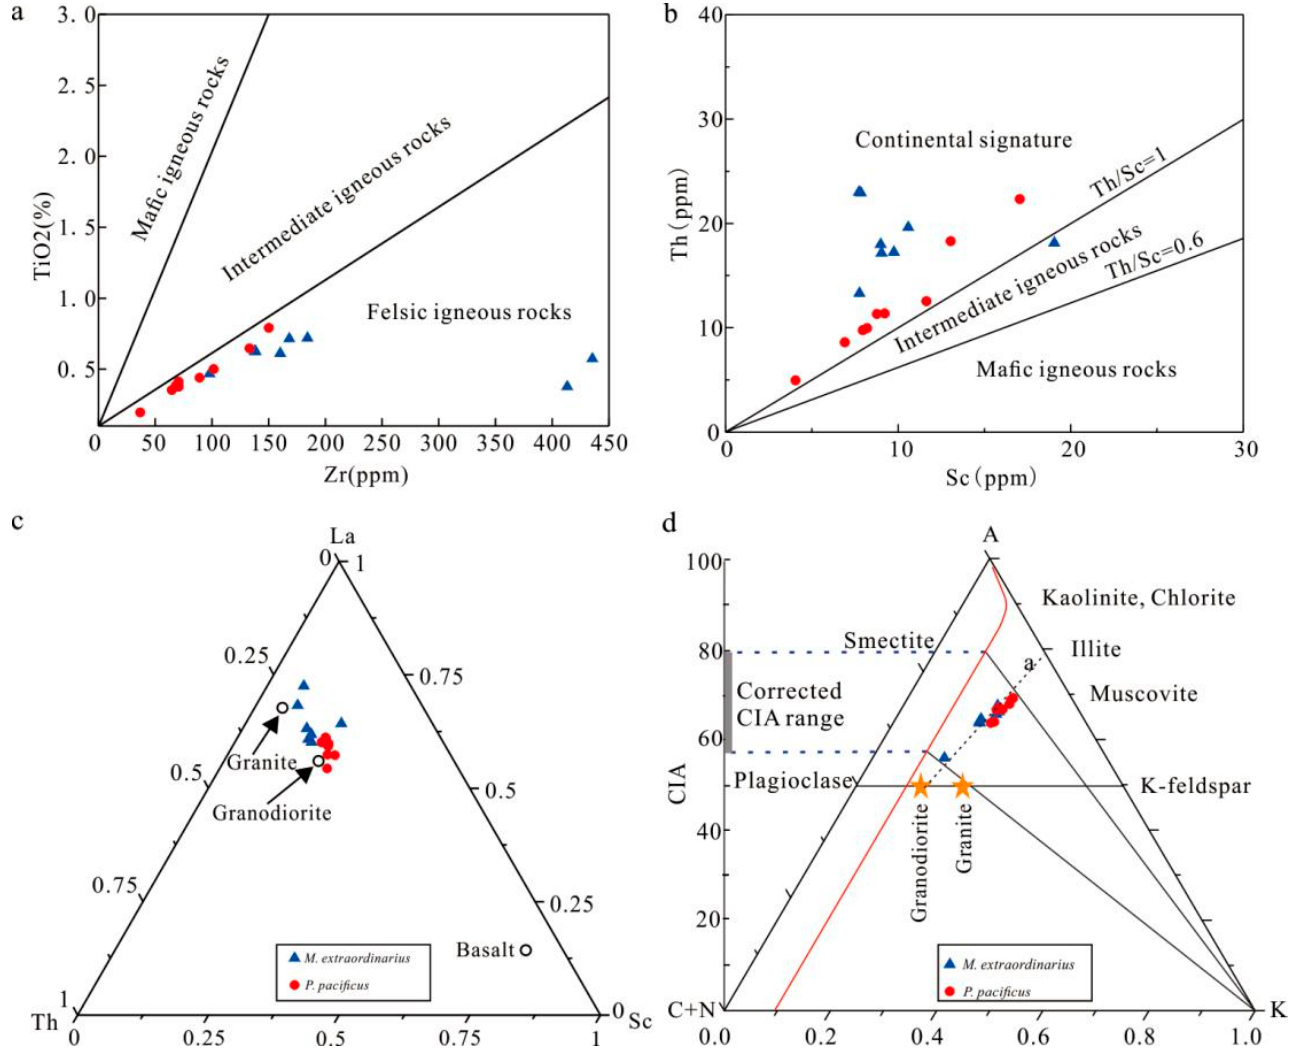
Figure 7. ( a ) Crossplot of TiO 2 versus Zr; ( b ) Crossplot of Th versus Sc; ( c ) La-Sc-Th ternary diagram showing source rock types from Well ZY5 and ( d ) A-CN-K (Al 2 O 3 − (CaO* + Na 2 O) − K 2 O) ternary diagram showing diagenetic K-metasomatism and the chemical index of alteration (CIA) ranges for different chemical weathering degrees.